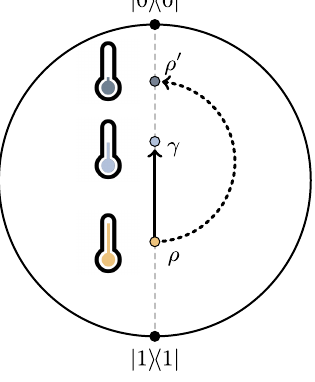
FIG. 3. Markovian cooling of a qubit. Classical memoryless processes can only cool the initial state ρ of a two-dimensional system to the thermal state γ at the environmental temperature (path along the solid-line arrow). Quantum memoryless dynamics with fixed point γ allows one to cool the system below that, all the way to the state ρ 0 with the lowest temperature achievable by classical processes with memory (path along the dotted-line arrow). For details, see Sec. IV B and, in particular, Fig.